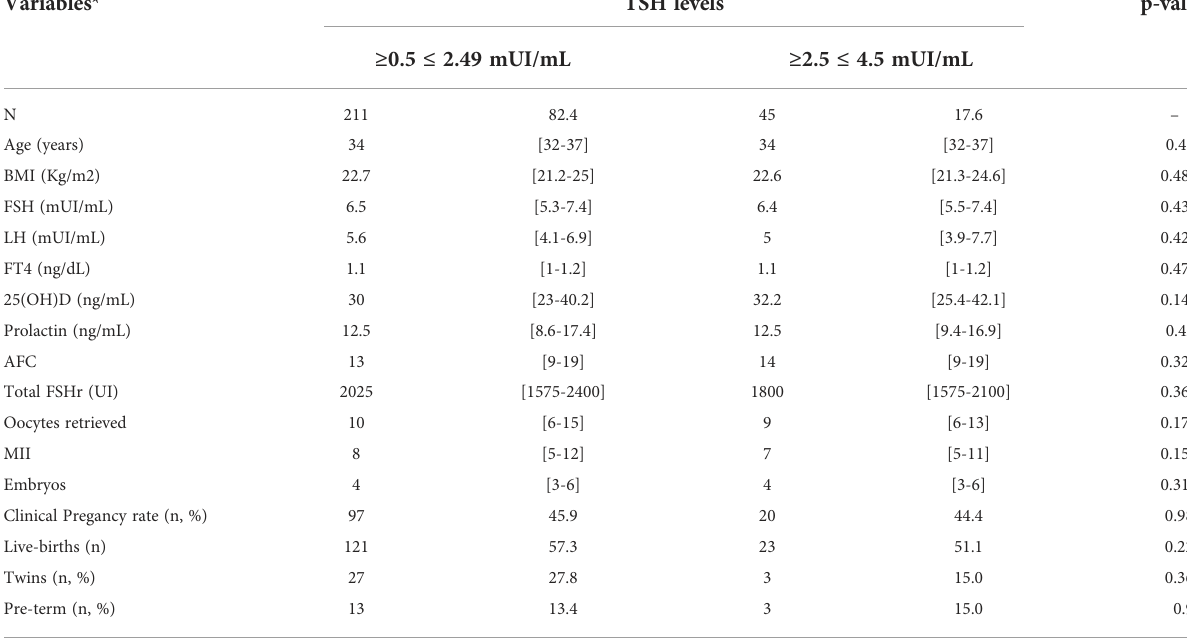
TABLE 1 Clinical characteristics, hormonal pro fi le and reproductive outcomes of infertile women according to TSH levels. Variables* TSH